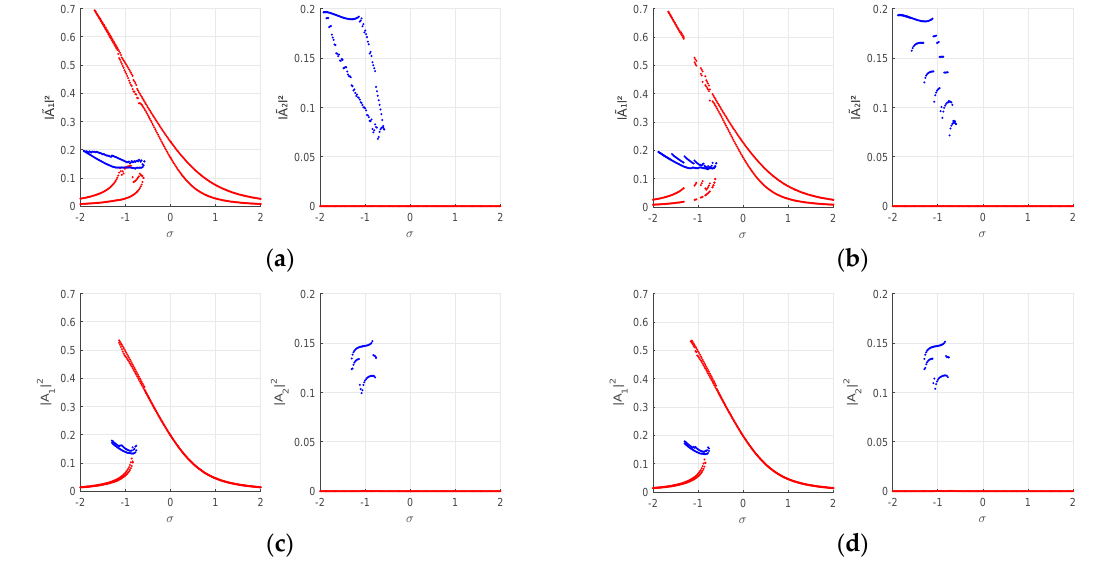
Figure 6. Envelopes of the amplitudes (cid:2038)(cid:3560) (cid:2869) and (cid:2038) (cid:2870) , of the pendulums physical responses computed, for ( a , b ) (cid:2012) (cid:3039) = 5% and ( c , d ) (cid:2012) (cid:3039) = 5% , using the LHS and gPCE methods, respectively.